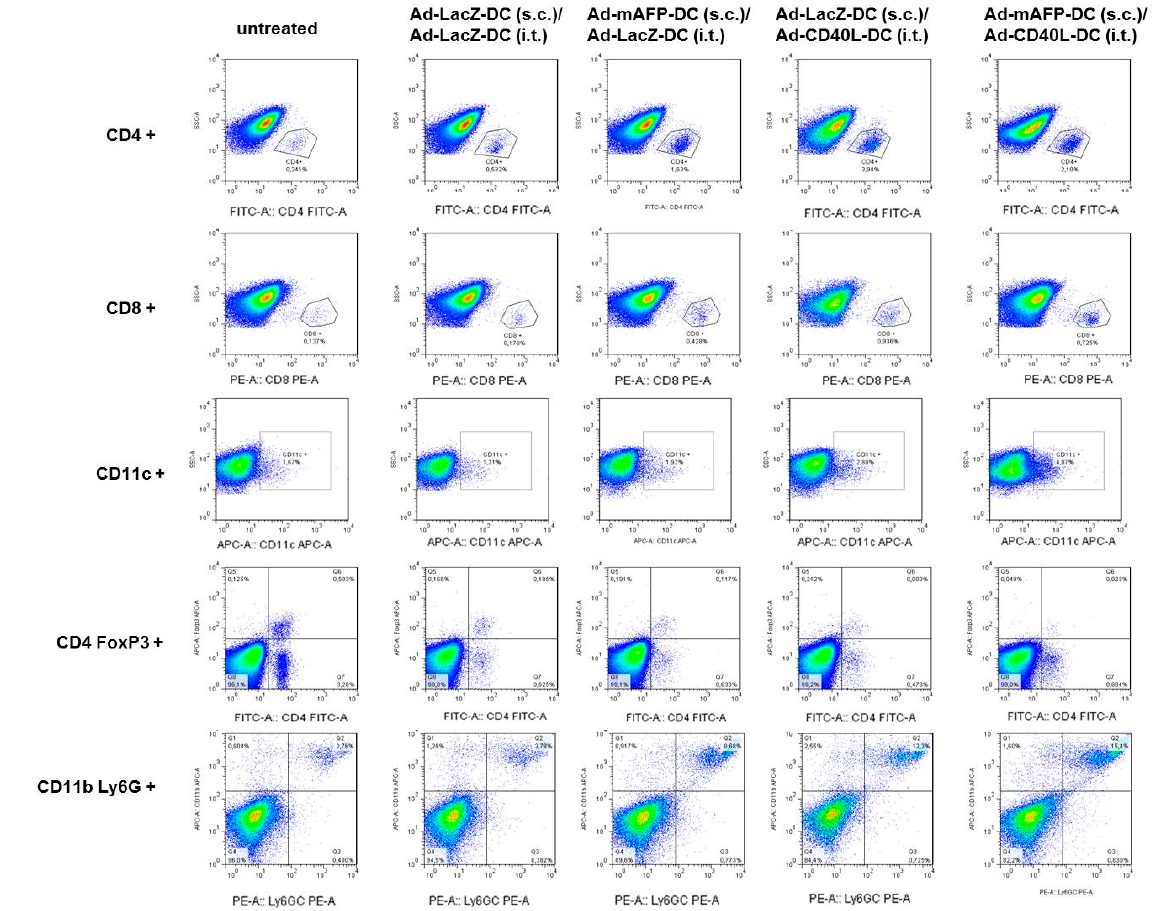
Figure 6. Flow cytometry of CD4, CD8, CD11c, Treg and MDSC of representative tumors.